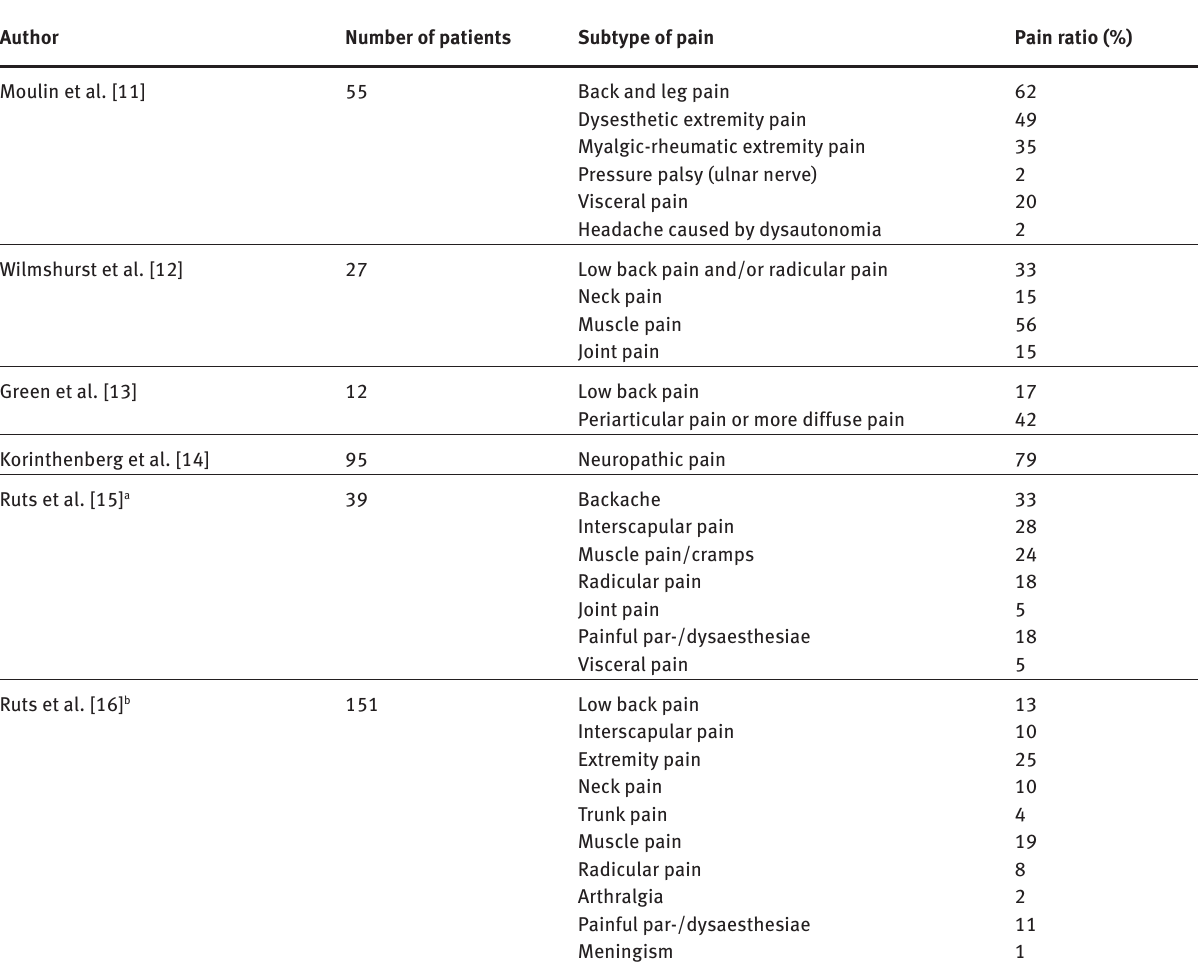
Table 3: Summary of studies on Guillain-Barré syndrome (GBS) and pain